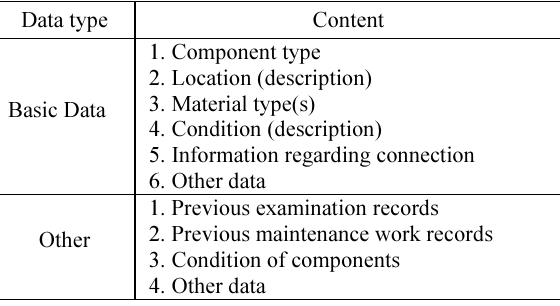
Table 1. GIS timber component data